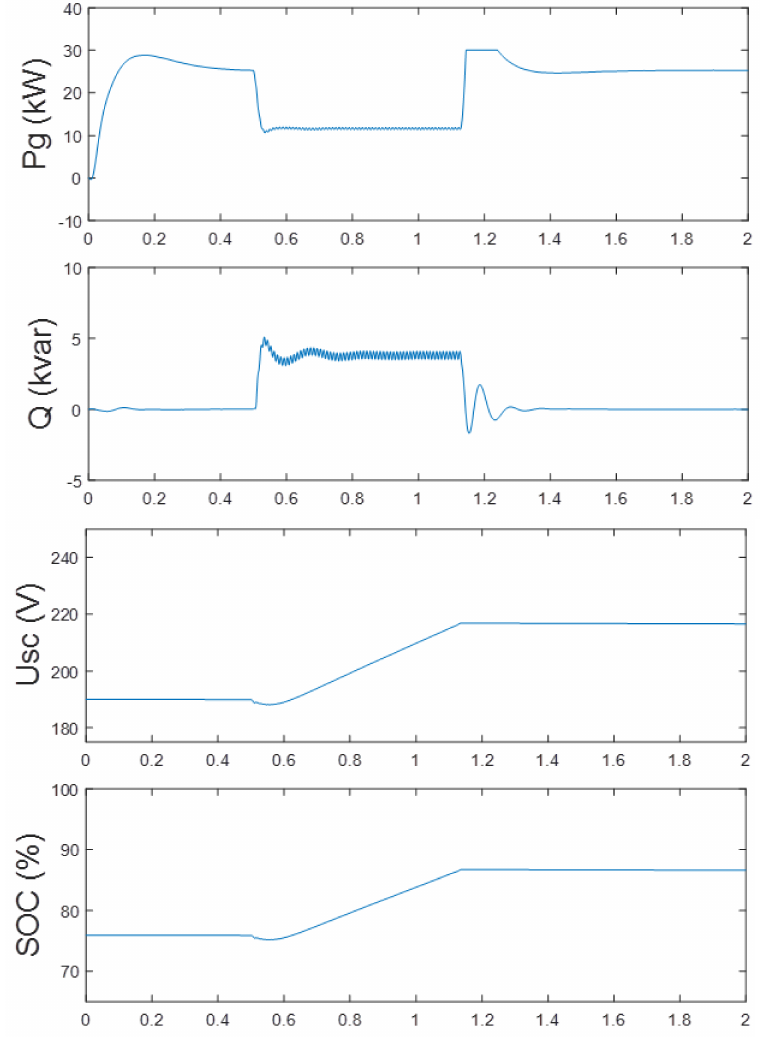
Figure 15. The simulation results of the overspeed-while-storing control under the double line-to- ground